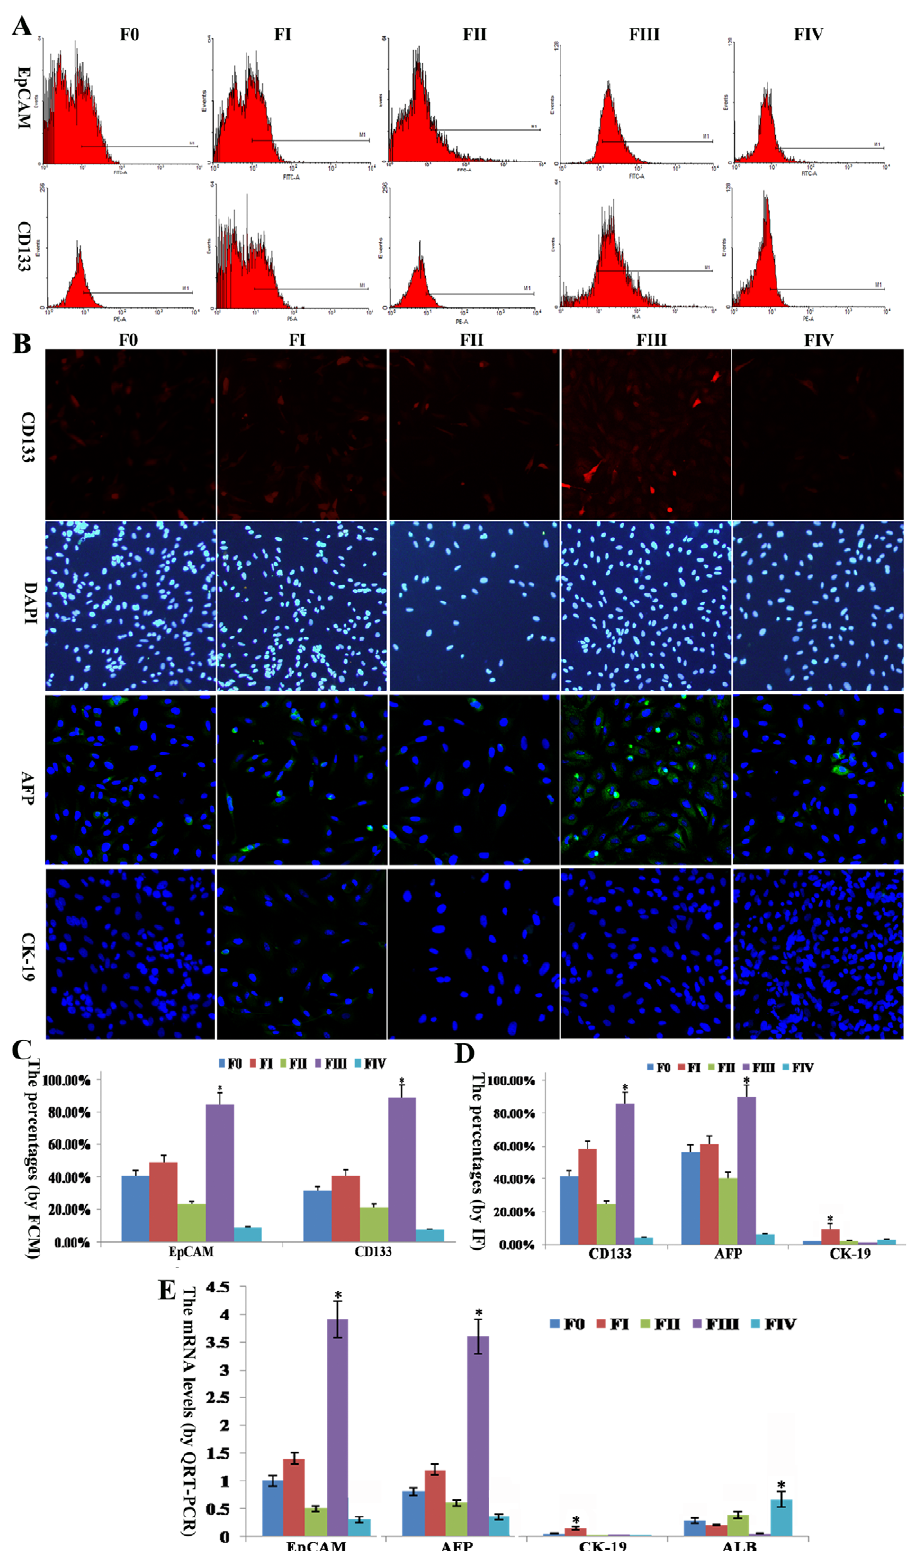
Figure 3. Expression of specific markers in each cell fraction. (A) Expression of stem cell markers (EpCAM and CD133) in each fraction determined by FCM. (B) Based on IF, CD133-positive cells (red, nuclei in blue) and AFP and CK-19-positive cells (green, nuclei in blue) were found to be included in different proportions. (C) Column chart reflecting the data obtained via FCM. (D) Column chart reflecting the data generated by IF. (E) qRT-PCR results of specific markers in freshly isolated cells from each fraction. F0 represents unfractionated HTCs; FI-IV indicates fractions I–IV after